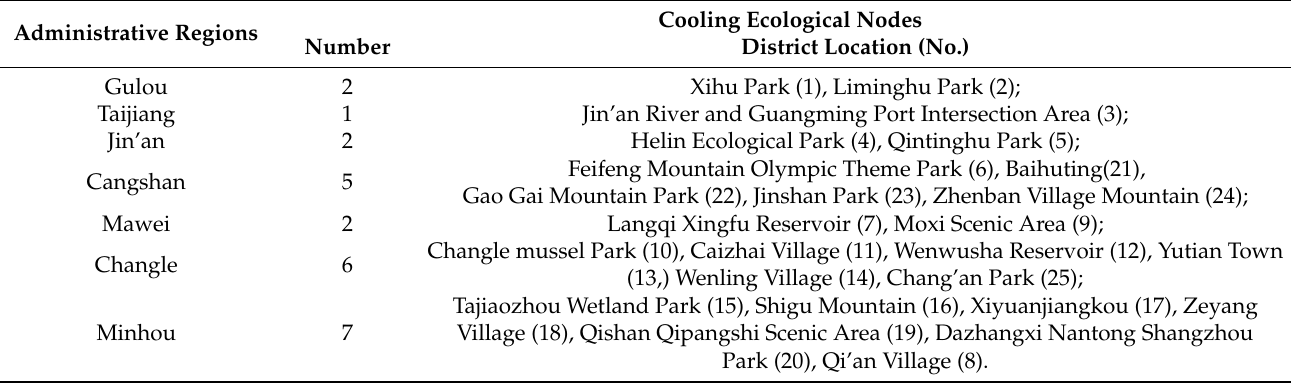
Table 4. New cooling ecological nodes.